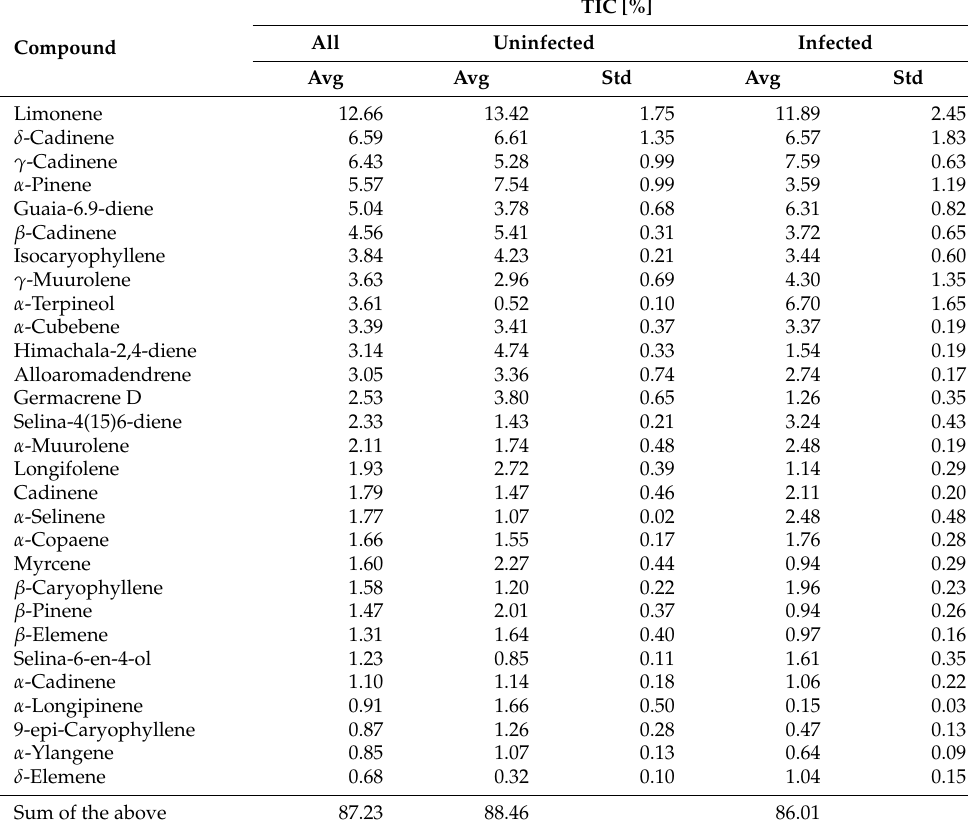
Table A2. Dominant chemical components identified by the GC–MS method ordered by average over all measurements. Average and standard deviation for uninfected and infected categories. The components for which Total Ion Current (TIC) was higher than 1% are selected. The last line represent the coverage of the listed components comparing to the total ion current collected during the GC-MS